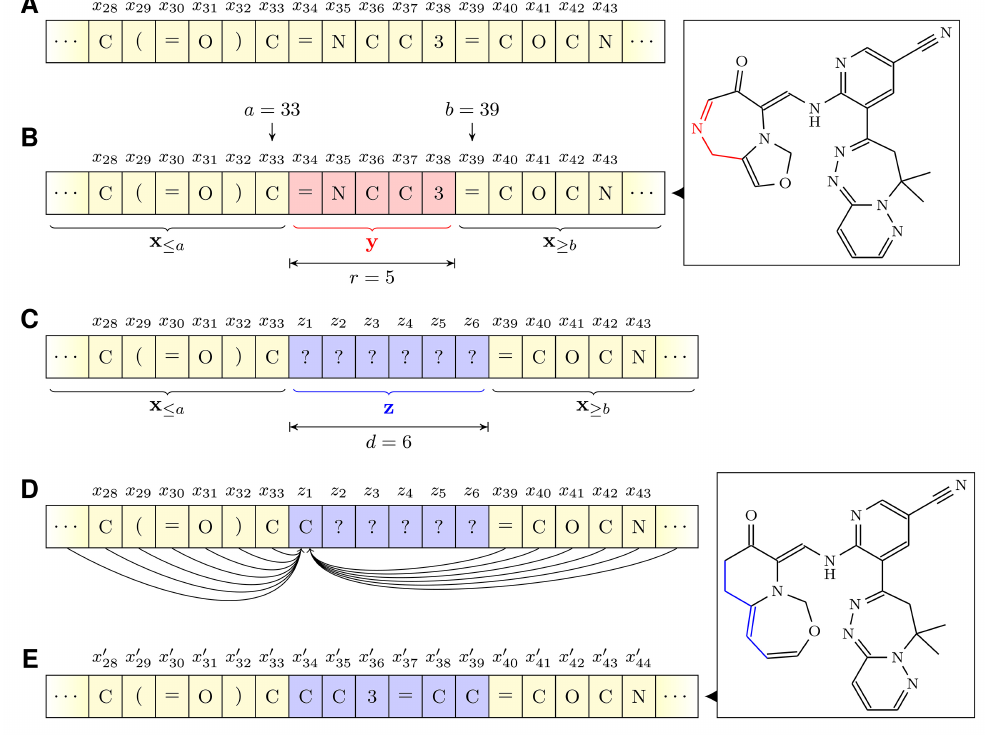
Figure 4. Illustration of the language model as a mutation operator. ( A ) A SMILES string to be mutated. ( B ) A random range y (red) of size r is selected for replacement. The top right molecular structure corresponds to the SMILES string with y highlighted in red. ( C ) The language model creates a new sequence z (blue) of length d . Note that d = r is not required. ( D ) Iteratively the language model calculates the z i values. For each z i all x ≤ a , z < i , and x ≥ b values are used as input. ( E ) After the language model processing, the resulting SMILES string is x (cid:48) = ( x ≤ a ) z ( x ≥ b ) . The bottom right molecular structure corresponds to the mutated SMILES string with the mutated part highlighted in